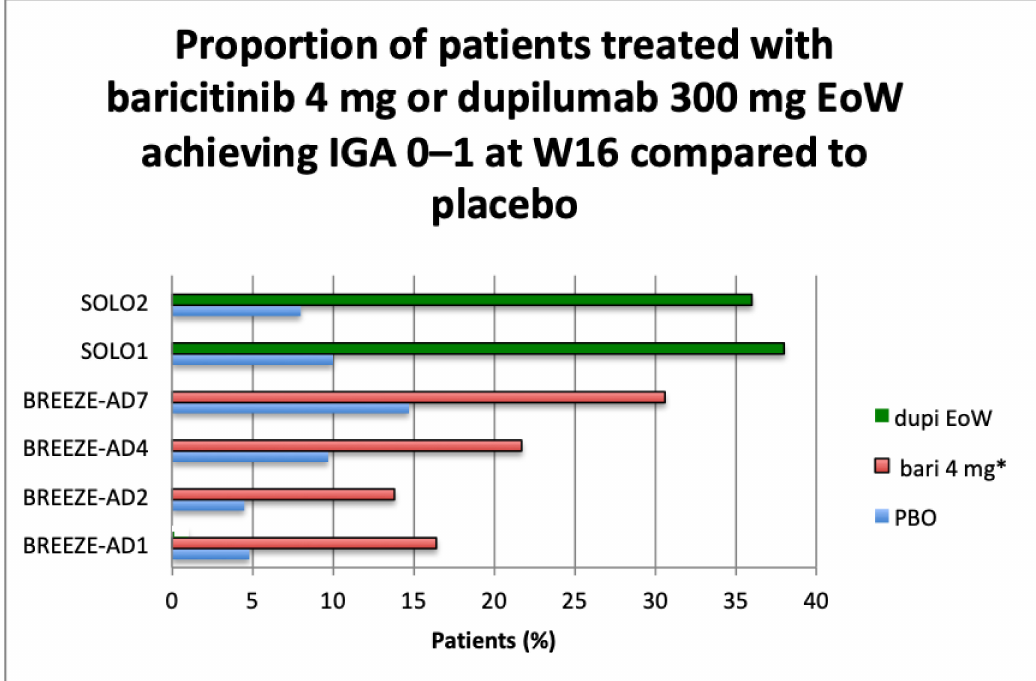
Figure 3. Overview of primary efficacy endpoint from RCTs: Proportion of patients treated with baricitinib 4 mg or dupilumab 300 mg EoW achieving IGA 0–1 at W16 compared to placebo. Abbreviations: PBO, placebo; IGA, investigator global assessment; W16, week 16; EoW, every other week; Dupi, dupilumab; bari, baricitinib. * In BREEZE-AD 4 and AD7, baricitinib was administered in association with topical corticosteroid as for protocol.